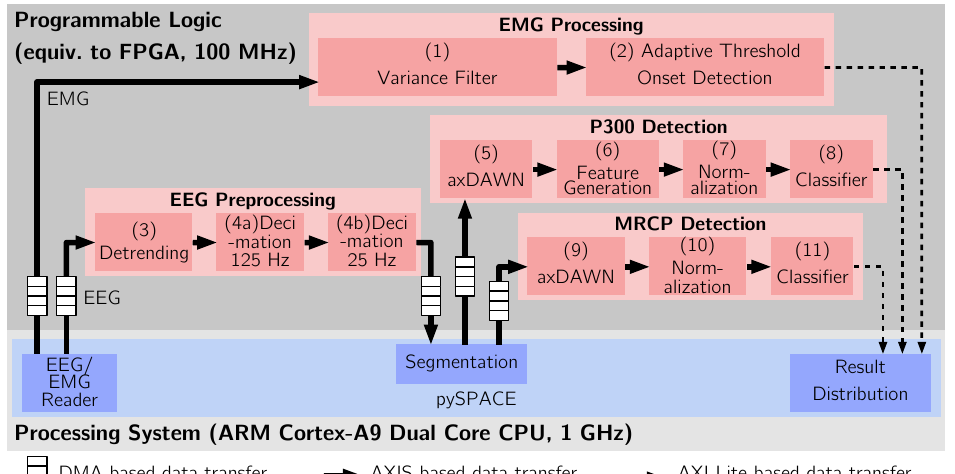
Figure 2. Hybrid parallel processing for electroencephalography (EEG) and electromyography (EMG) detection. The numbers shown in each processing step refer to the detailed description in Section